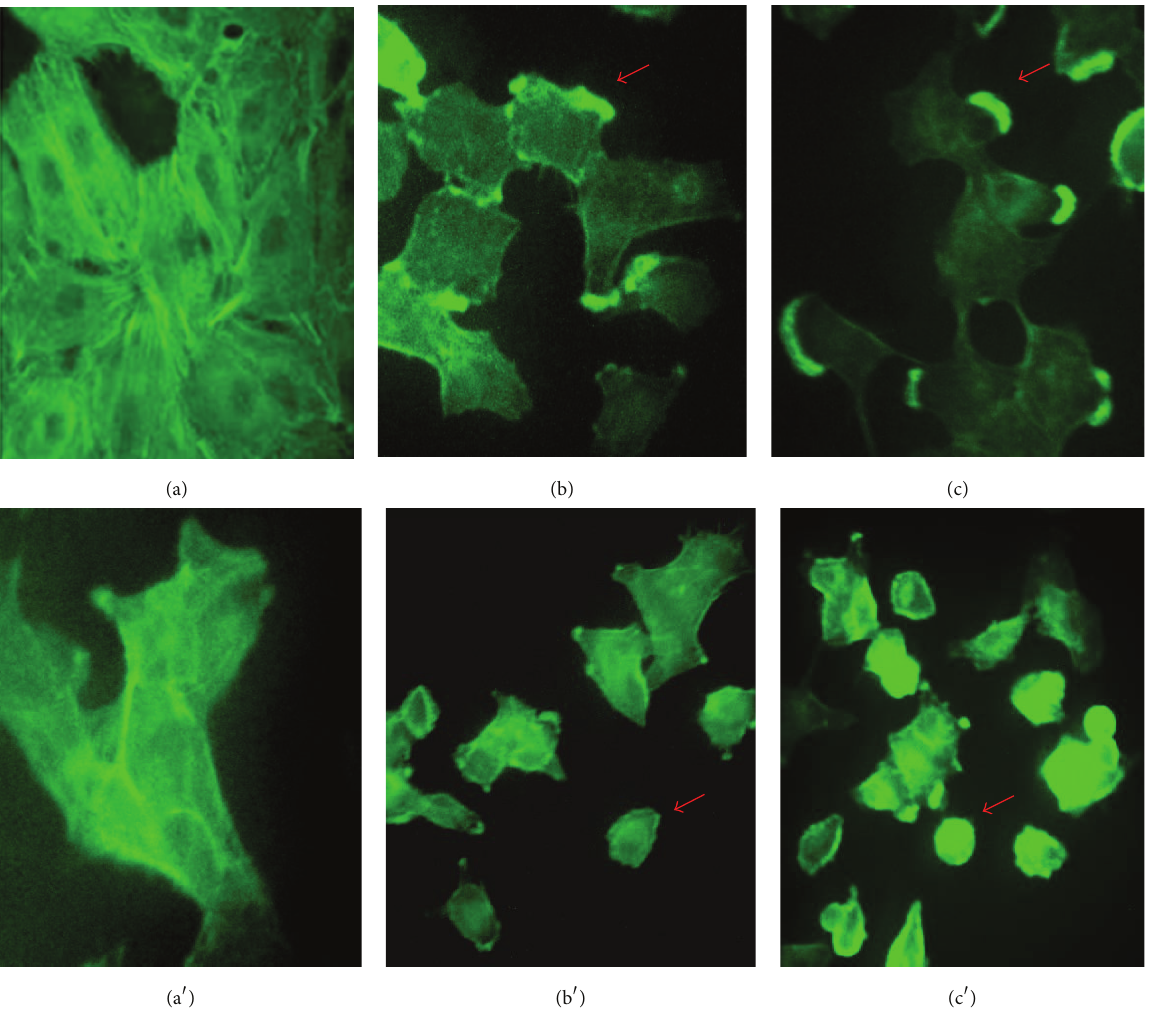
Figure 6: Microfilaments of cells exposed to SeMet and SSe. Controls (a and a 󸀠 ); cells treated with 0.5 and 1.5 mM Se as SeMet (b and c) and SSe (b 󸀠 , c 󸀠 ), respectively, for 48h. Arrows point to the fluorescent plates at the edges of the membrane and loss of spreading